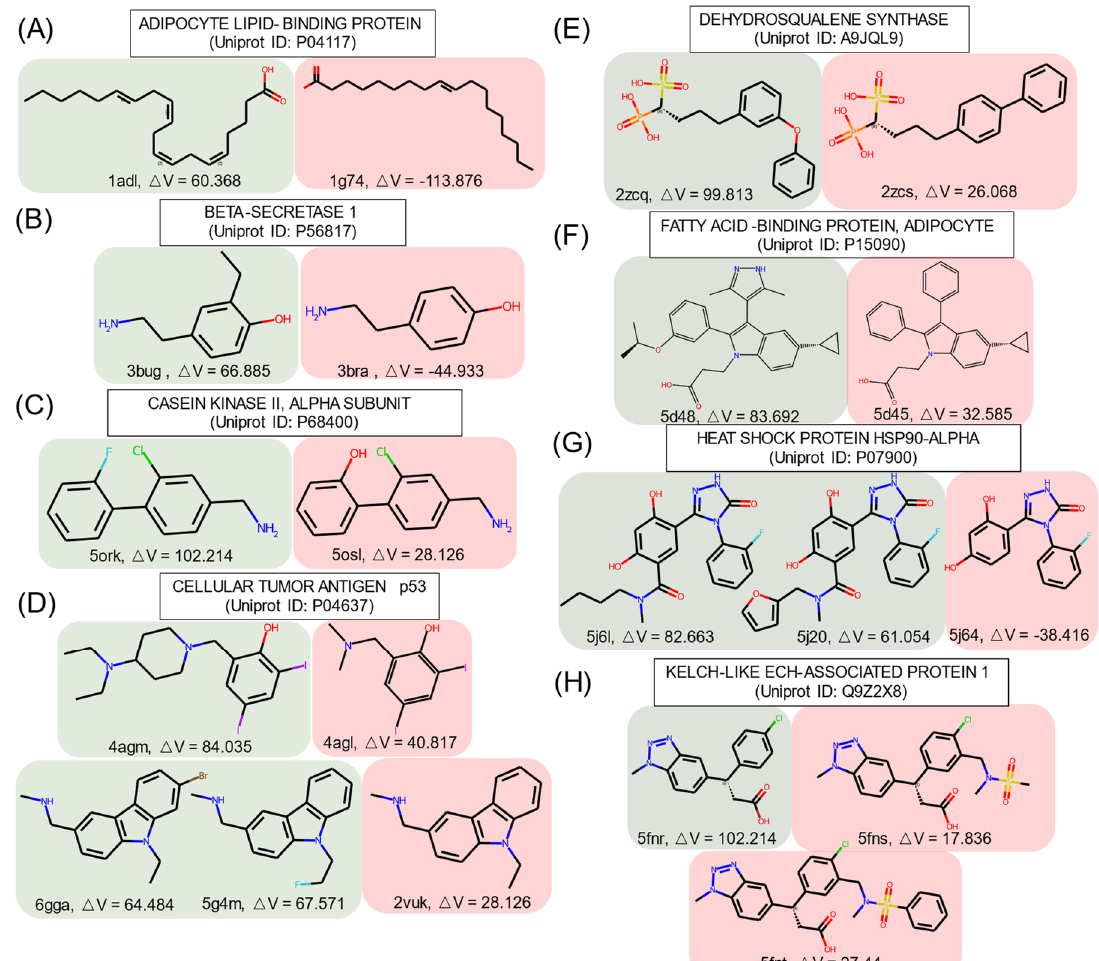
Figure 3. Similar structures that are identified as inducers and non-inducers in the PDBbind set. Red: inducer; blue: non-inducer. Δ V represents the volume difference between the apo and holo pockets. The unit of △ V is Å 3 .